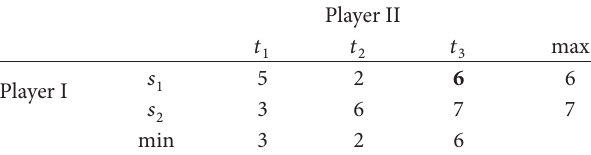
Table 4: Zero-sum